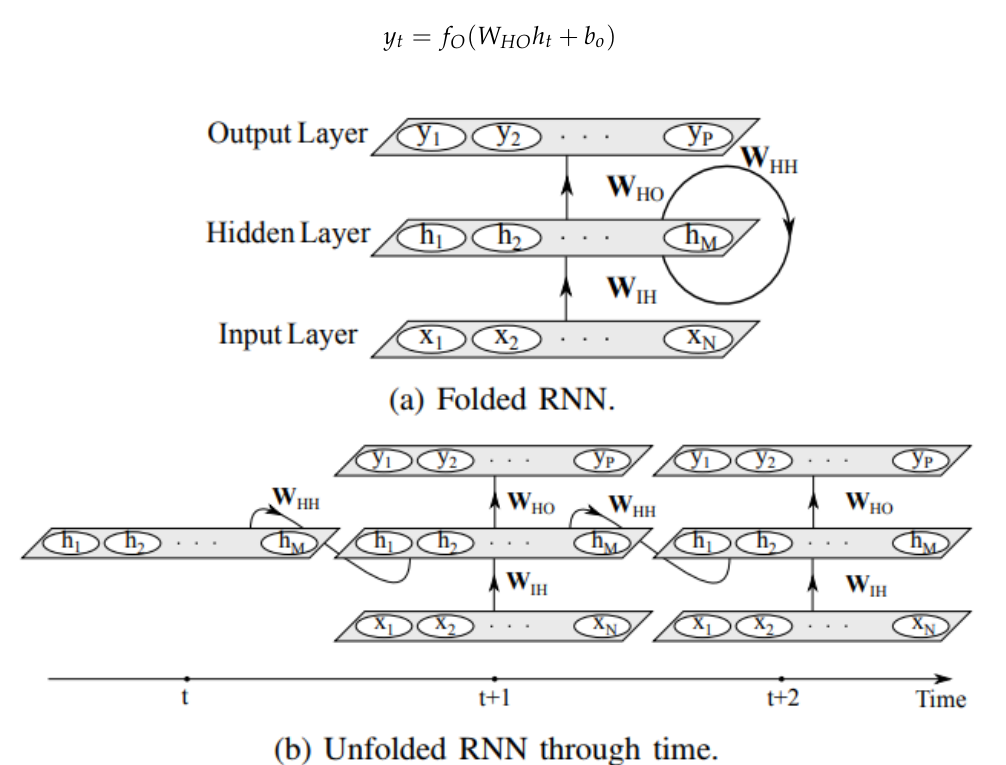
Figure 1. Simple Recurrent Neural Network (RNN) architecture. For the sake of simplicity biases are ignored. Source: